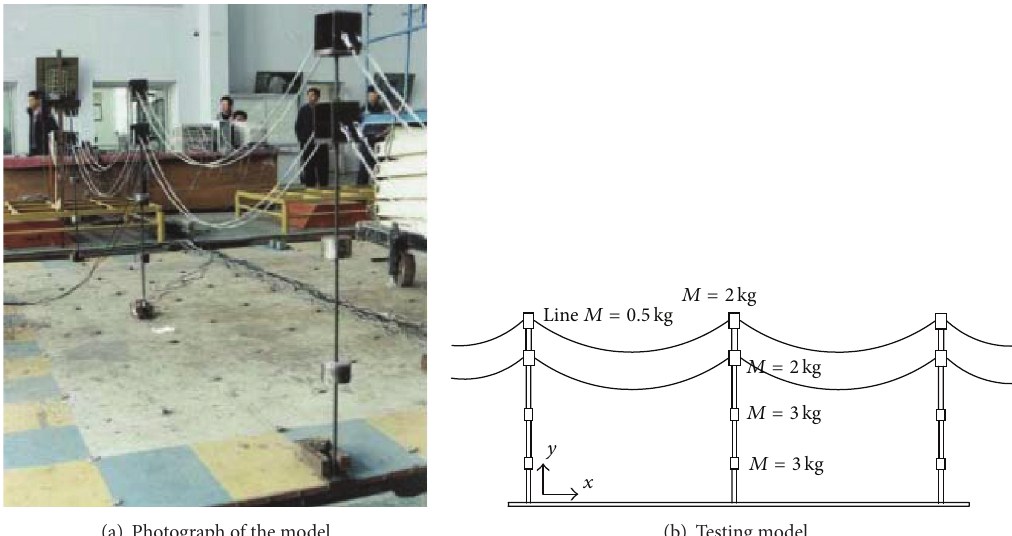
Figure 11: Elevation of testing